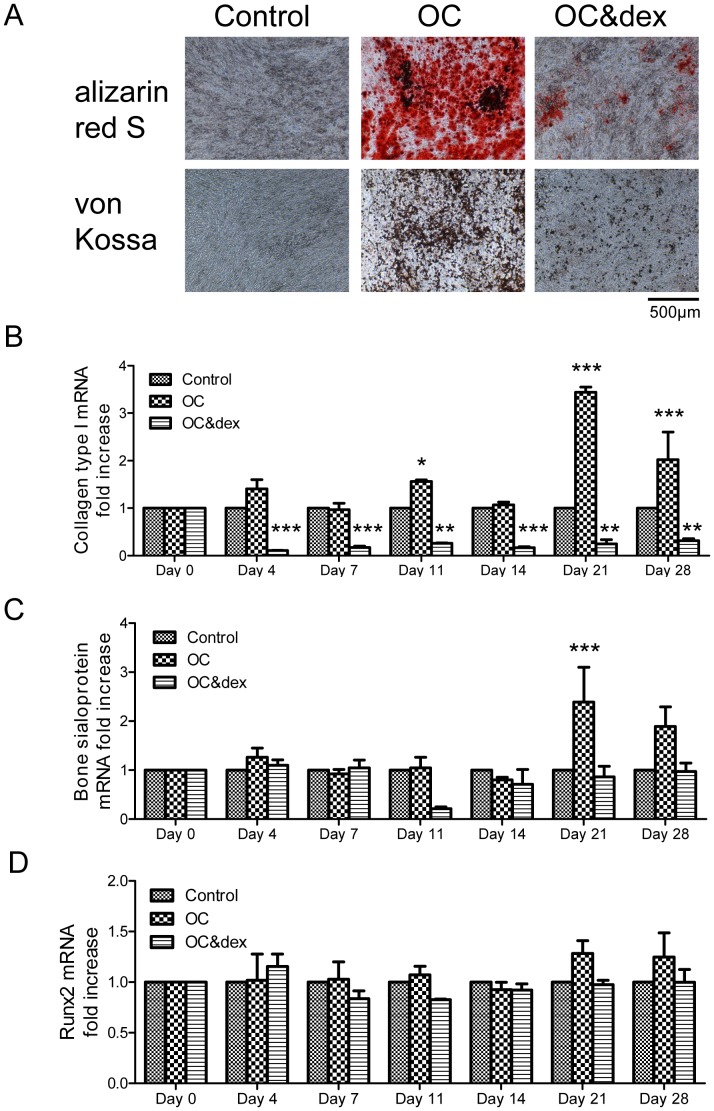
Investigating the expression of several bone markers in mineralizing 4T1 cells using real-time RT-PCR.(A) Alizarin red S and von Kossa staining of 4T1 cells after 28 days as viewed under a light microscope at 100× magnification (n = 3). The scale bar represents 500 µm. Positive staining was observed for calcium (red) and calcium phosphate (black/brown) using alizarin red S and von Kossa staining respectively, in the OC group and to a lesser extent in the OC&dex group. (B) There is a decrease in col1a1 (collagen type 1, alpha 1) mRNA expression in the OC&dex group compared to the control group from days 4–28. In contrast, there is increased expression of col1a1 in the OC group on days 11, 21 and 28. *P<0.05 OC vs. control on day 11. **P<0.01 OC&dex vs. control on days 11, 21 and 28. ***P<0.001 OC vs. control on days 21 and 28, also OC&dex vs. control on days 4, 7 and 14. (C) On day 21 there is an increase in the expression of bone sialoprotein (BSP) mRNA in the OC group compared to the control and OC&dex groups. ***P<0.001 OC vs. control and OC&dex groups on day 21. (D) No changes in the expression of Runx2 mRNA were detected between the different treatment groups over time. All real-time RT-PCR results are expressed in arbitrary units and normalized to the control samples at each time point. Each point represents the mean +/− SEM, n = 3, two-way ANOVA. OC (osteogenic cocktail) = 50 µg/ml ascorbic acid and 10 mM β-glycerophosphate. Dex = 100 nM dexamethasone.